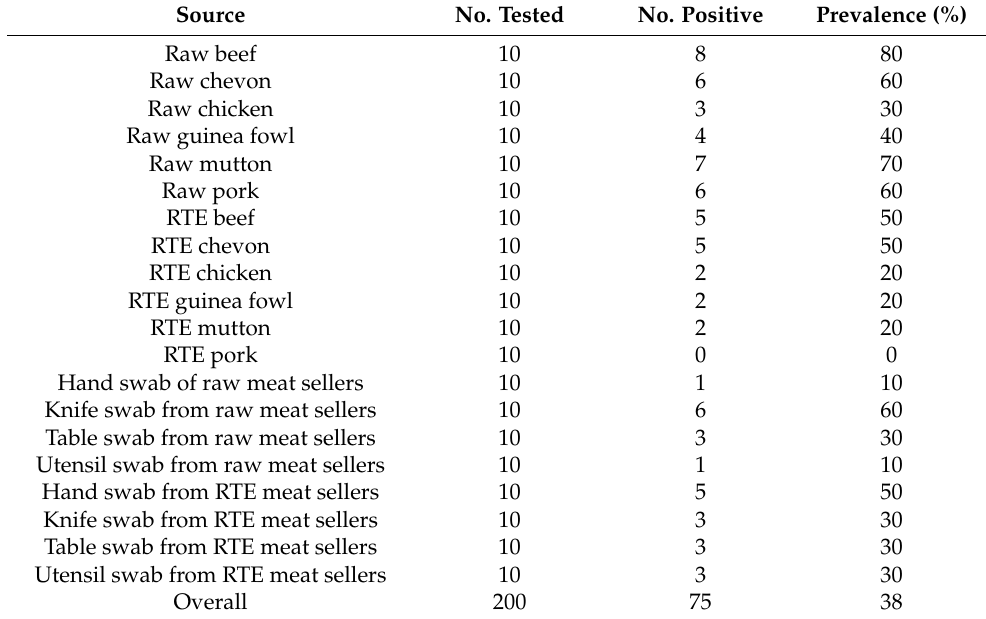
Table 1. Distribution of Escherichia coli in raw meats, ready-to-eat (RTE) meats and their related samples. Source No. Tested No. Positive Prevalence